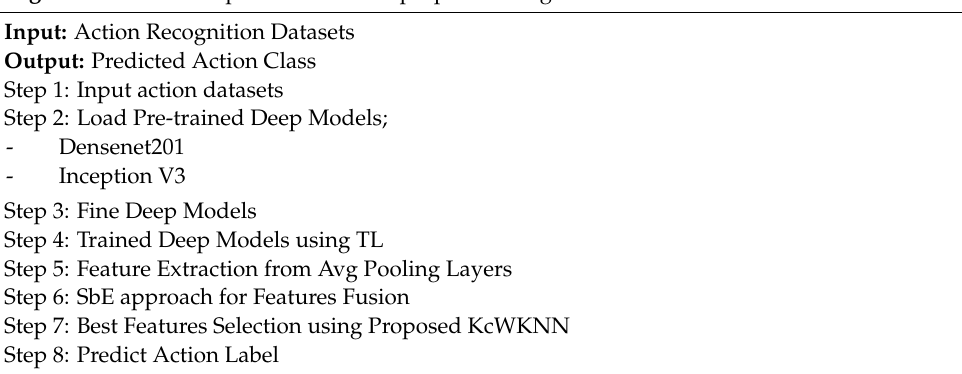
Figure 7. Proposed flow diagram of best feature selection. Algorithm 1. The complete work of the proposed